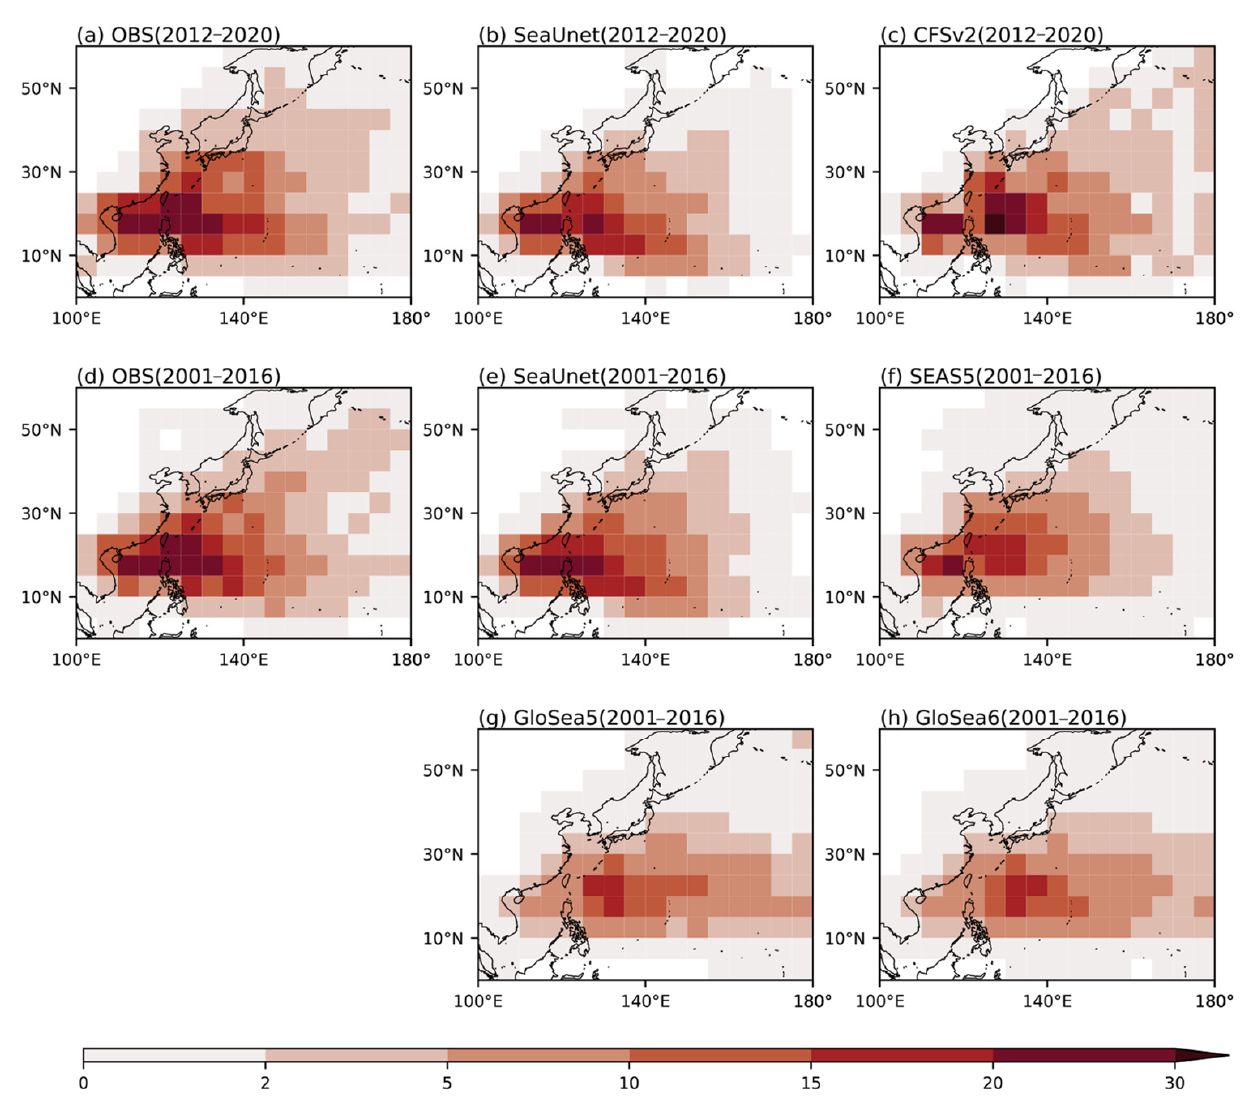
Figure 2. Climate mean of WNP TC track density from June to November predicted in June. ( a ) Observation for the time range of 2012–2020; ( b ) predicted by SeaUnet; ( c ) predicted by CFSv2 for the time range of 2012–2020; ( d ) observation for the time range of 2001–2016; ( e ) predicted by SeaUnet; ( f ) predicted by SEAS5; ( g ) predicted by Glosea5; ( h ) predicted by Glosea6 for the time range of 2001–2016.